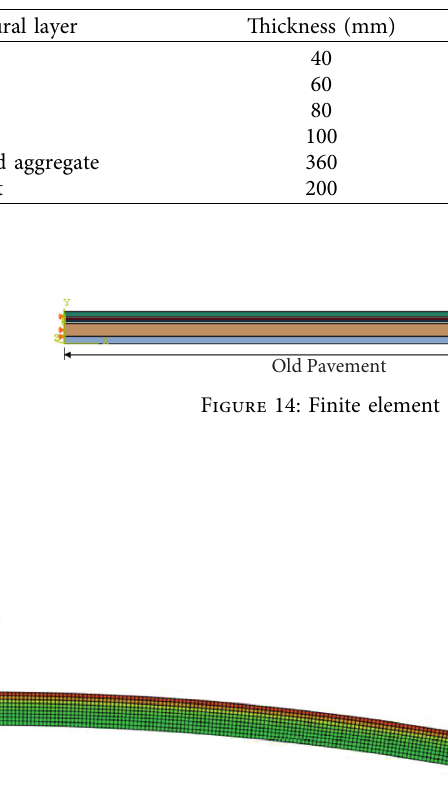
Table 4: Calculation parameters of the new pavement structure layer.